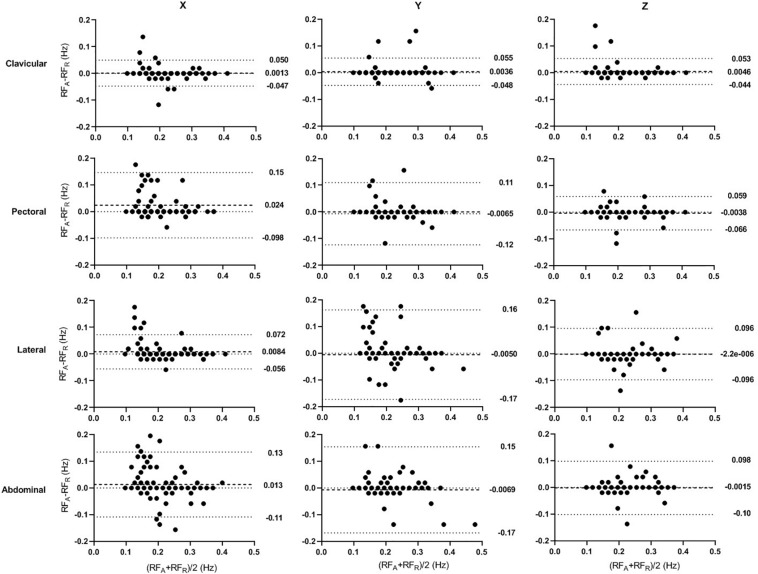
Bland–Altman Plots of the accelerometer-derived and reference RFs in seated posture. The x- and y-axes indicate the mean and difference of the accelerometer-derived and the corresponding reference RFs, respectively. The dashed lines show the mean bias. The limits of agreement (LoA) mean ± 1.96 SD interval of difference are given with the dotted lines.